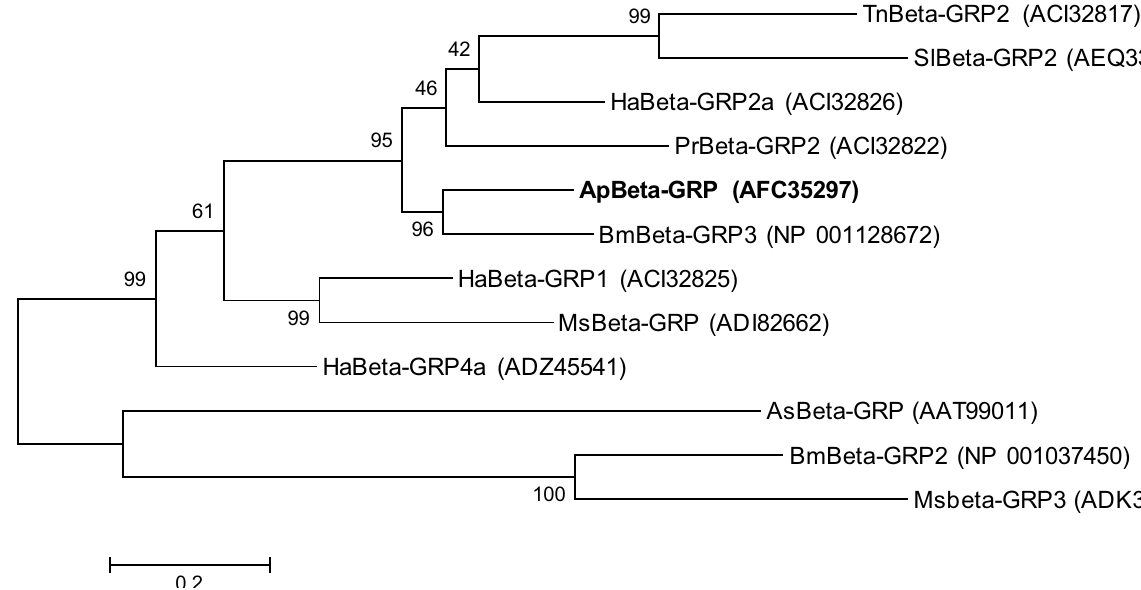
4. Molecular (cid:83)(cid:75)(cid:92)(cid:79)(cid:82)(cid:74)(cid:72)(cid:81)(cid:72)(cid:87)(cid:76)(cid:70)(cid:3) (cid:68)(cid:81)(cid:68)(cid:79)(cid:92)(cid:86)(cid:76)(cid:86)(cid:3) (cid:82)(cid:73)(cid:3) (cid:533) -1,3-glucan recognition proteins (Beta-GRP) from different species. The evolutionary history was inferred by using the Maximum Likelihood method. The tree with the highest log likelihood ( (cid:177) 7627.2903) is shown. The percentage of trees in which the associated taxa clustered together is shown next to the branches. The tree is drawn to scale, with branch lengths measured in the number of substitutions per site. Ap, A. pernyi ; As, Armigeres subalbatus ; Bm, B. mori ; Ha, Helicoverpa armigera ; Hp, Hepialus pui ; Lo, Lonomia obliqua ; Ms, M. sexta ; Pr, Pieris rapae ; Tn, Trichoplusia ni